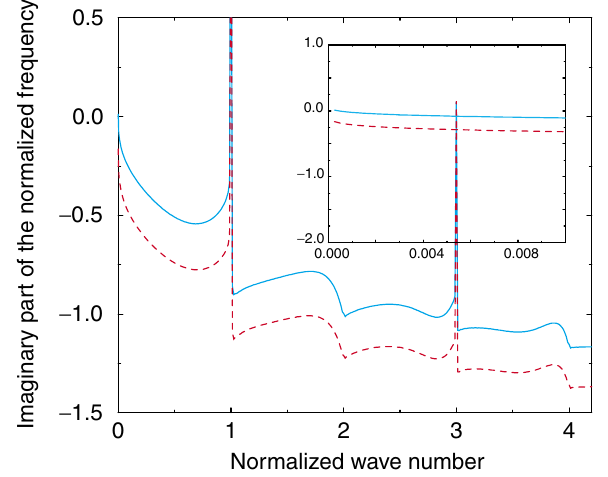
FIG. 6. (Color) The imaginary part of the normalized fre- quency (cid:12) as a function of the normalized wave number k=k where k is the on-axis wiggler fundamental radiation wave 0 number. The solid curve is for the wigglers in the NLC main damping ring and the dashed curve is for the TESLA damping